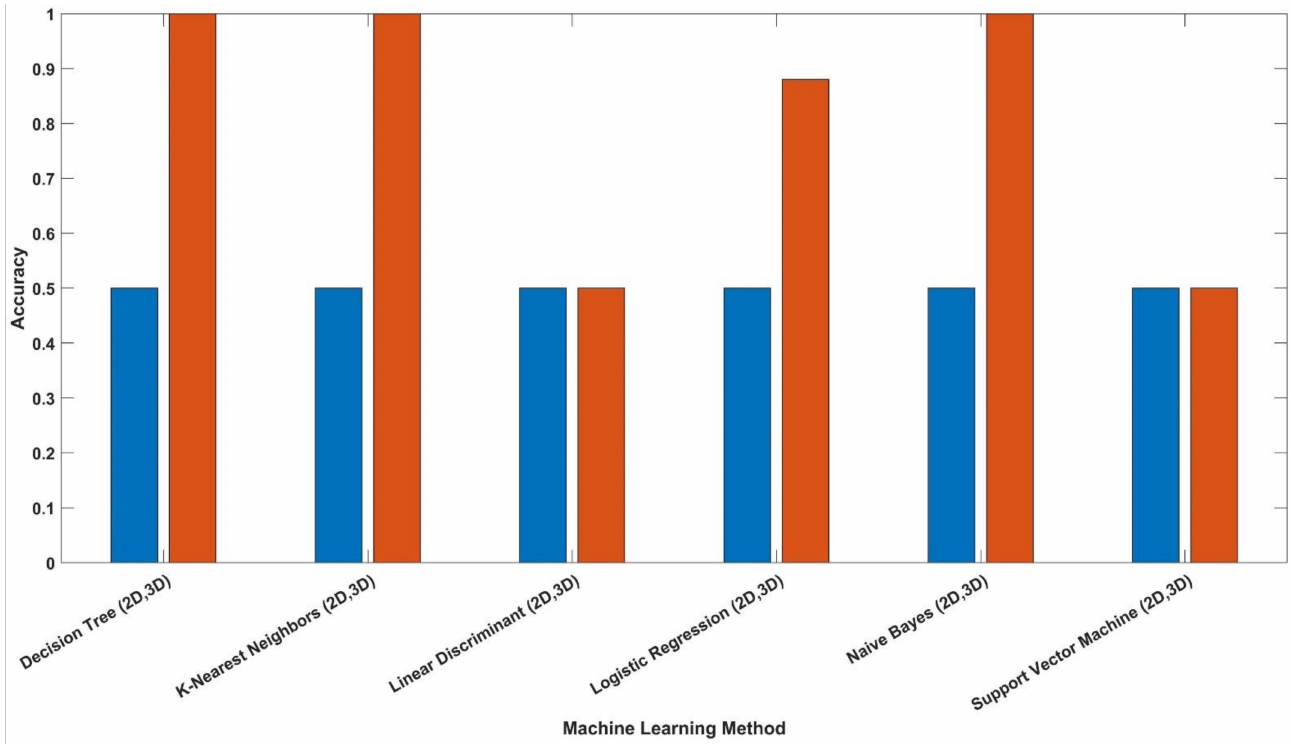
Figure 6. Isotropic test set accuracy results for 2D and 3D input to the ML model using different ML